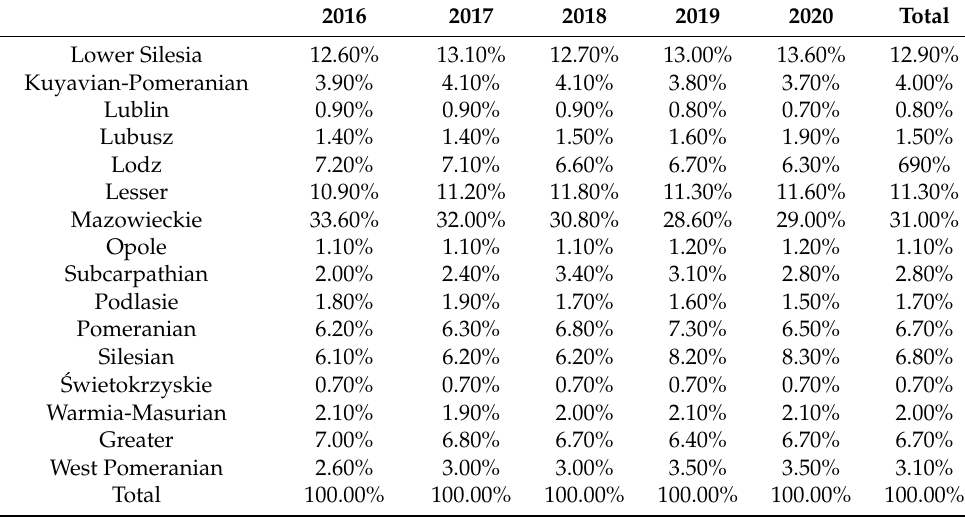
There were also no significant differences in terms of the distribution of the respon- dents by year of measurement and the voivodeship of residence (see Table A2). Table A2. Distribution of voivodeships depending on the year of